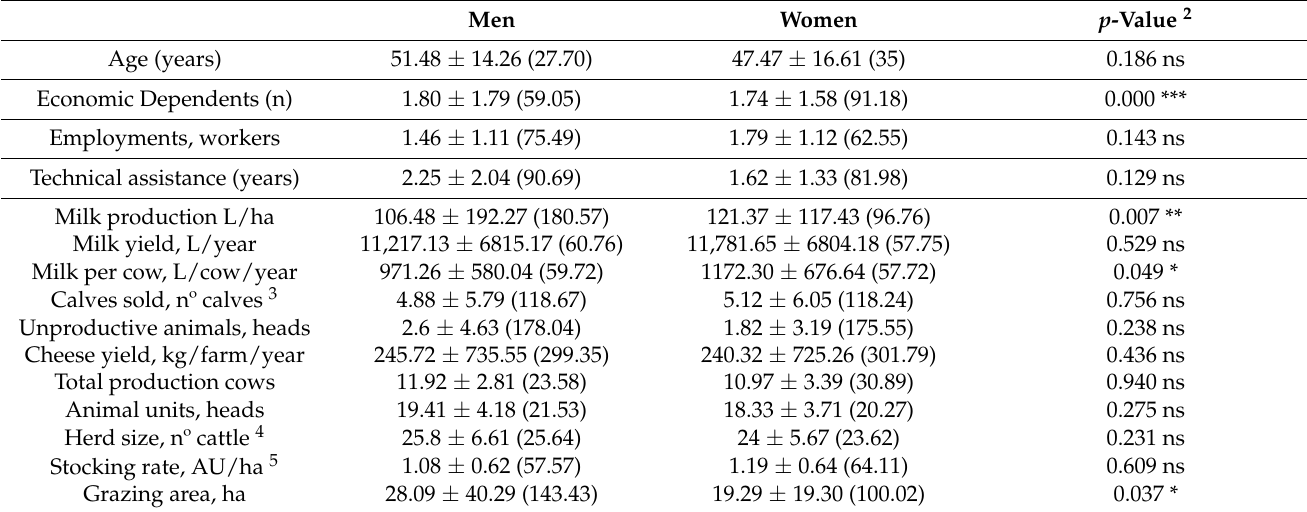
Table 7. Technical and structural indicators by gender (Mean ± SD (CV, %) 1